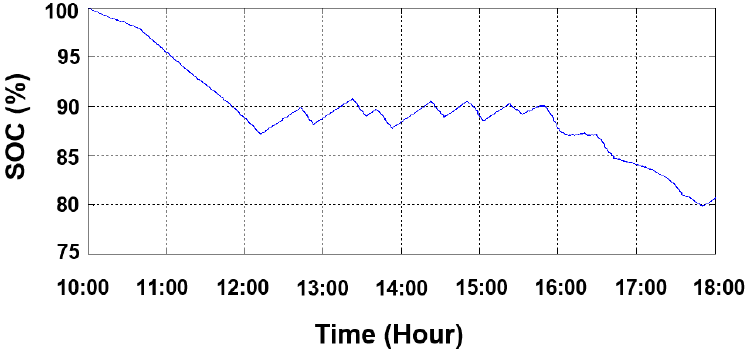
Figure 19. Fuzzy-based EMS in sunny day: ESS SOC.